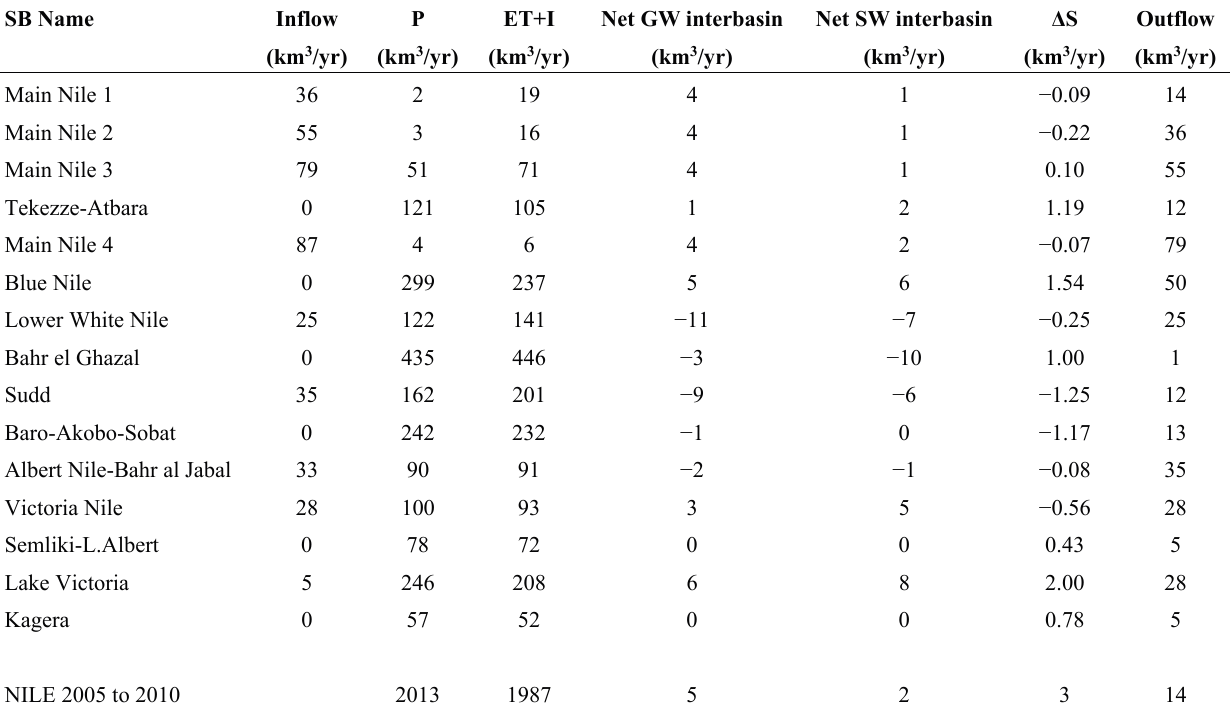
Table 4. Annual water balance by sub-basin, averaged for the period 2005–2010. Inter-basin transfer is estimated from closure of the water balance of each